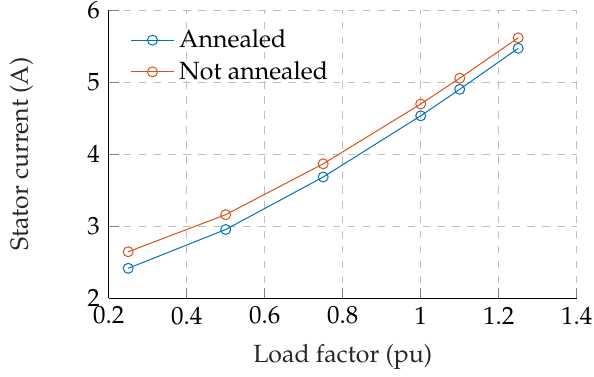
Figure 5. Experimental results of stator current versa load